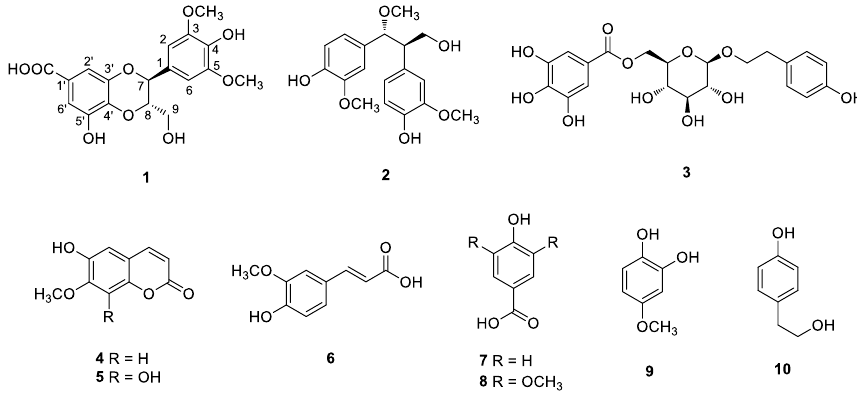
Figure 1. Chemical structures of compounds 1 – 10 .